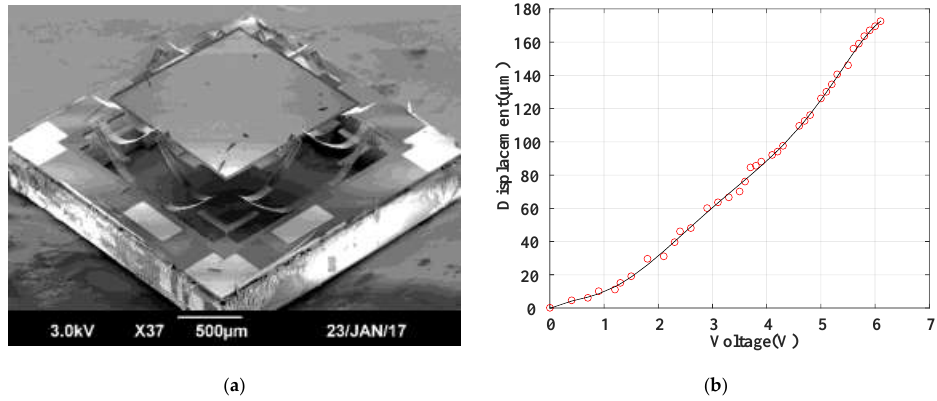
Figure 2. ( a ) Scanning electron microscope (SEM) of an electrothermal micro-electro-mechanical system (MEMS) mirror; ( b ) measured vertical displacement versus applied voltage on bimorph